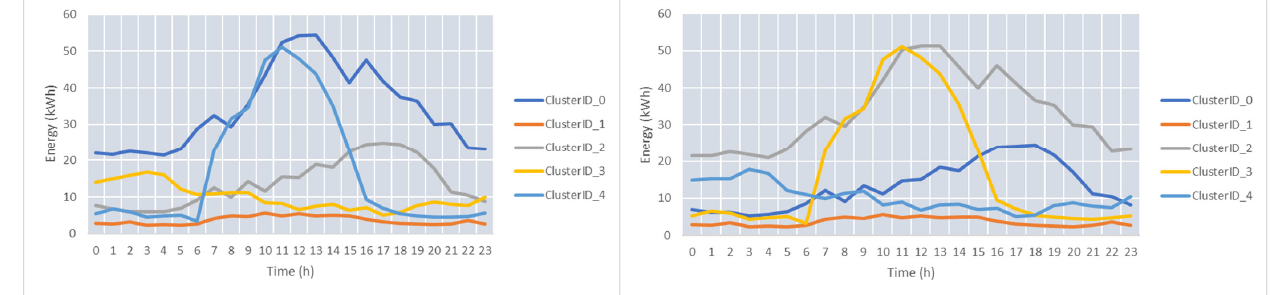
Figure 13. Energy peak and valley cluster centroids.